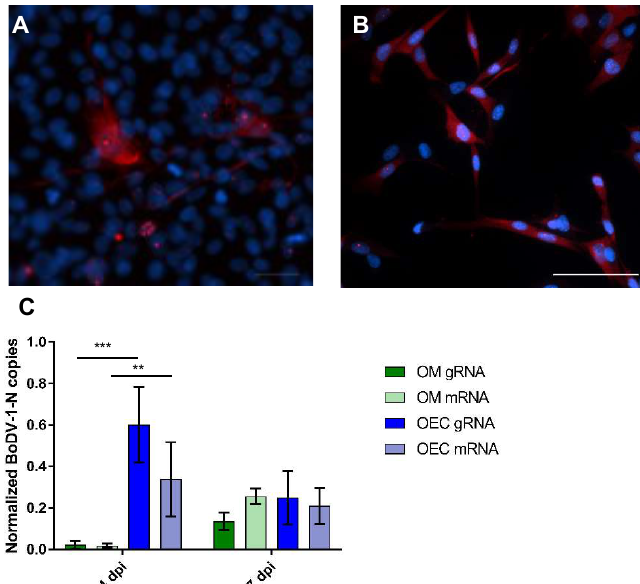
Figure 6. Infection of the OM culture and OECs. ( A ) Rat OECs at five dpi; ( B ) Canine OECs at six dpi. ( A , B ) Immunofluorescence—Bo18: Cy3. Nuclear and cytoplasmatic staining: DAPI. Arrows: BoDV-1-N. Insert: magnification of a cell at six dpi. Scale bars: 50 µm. Arrows: intranuclear granular staining for BoDV-1. ( C ) Quantitative real time RT-PCR, normalized Mammalian Bornavirus 1 nucleoprotein BoDV-1-N copy numbers at four and seven dpi for viral genomic RNA (gRNA) and messenger RNA (mRNA) for the cultures of the olfactory mucosa (OM) and for rat olfactory ensheathing cells (OECs), respectively. Arithmetic mean, error bars: standard deviation. ** p = 0.0080, *** p = 0.0002.